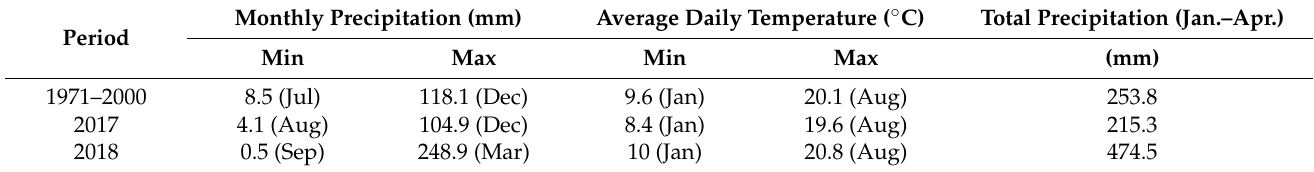
Table 1. Temperature and precipitation data for the study region and the periods 1971–2000 [41], 2017 and 2018 [42]. The data are from the meteorological station of Monte Real (Leiria, Portugal). Monthly Precipitation (mm) Average Daily Temperature ( ◦ C) Total Precipitation (Jan.–Apr.)